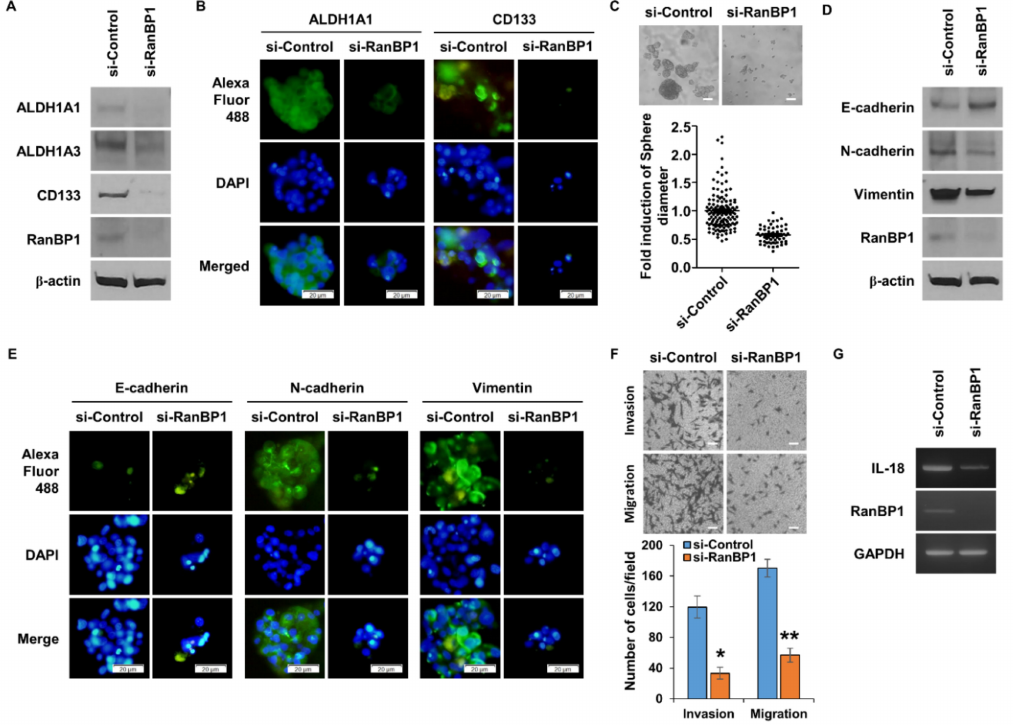
Figure 5. Characteristics of CSC and EMT events regulated by RanBP1 in glioma. ( A ) Compari- son of the expression of GSC marker proteins by RanBP1 gene suppression in GSCs. U87 cells are differentiated into GSCs using TM. ( B ) Comparison of the marker protein expression according to the expression of RanBP1 using ICC in GSCs. ( C ) Comparison of differences in sphere forma- tion according to the expression level of RanBP1 in GSCs. Experiments performed in triplicate. ( D ) Comparison of the EMT marker protein expression after RanBP1 gene suppression using si-RNA. ( E ) Confirmation of EMT marker protein expression according to the expression of RanBP1 using ICC. ( F ) Analysis of cell migration and invasion ability after the suppression of RanBP1 expression using si-RNA. ( G ) Analysis of regulation of IL-18 expression by RanBP1 in GSCs. Error bars represent mean ± SD. Triplicate samples. * p < 0.001, ** p < 0.0005, versus control. Scale bar = 50 µ